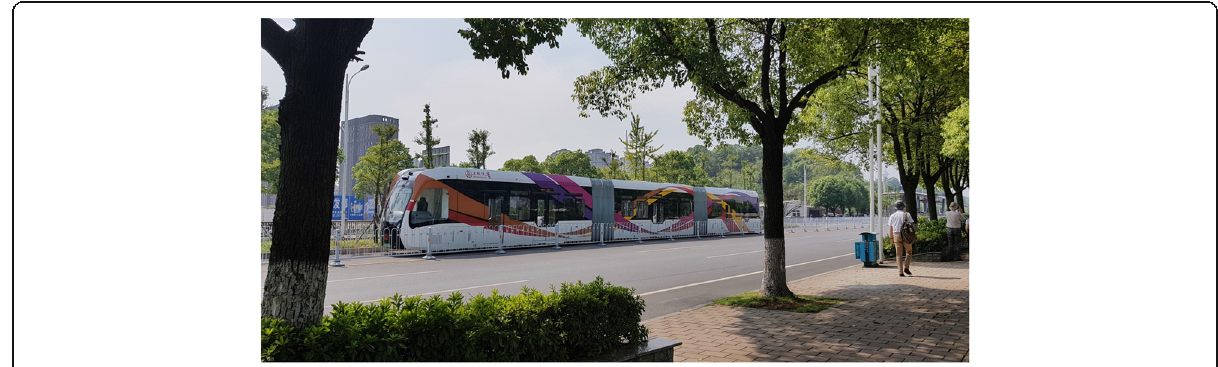
Fig. 8 A Chinese Trackless Tram in Zhu Zhou